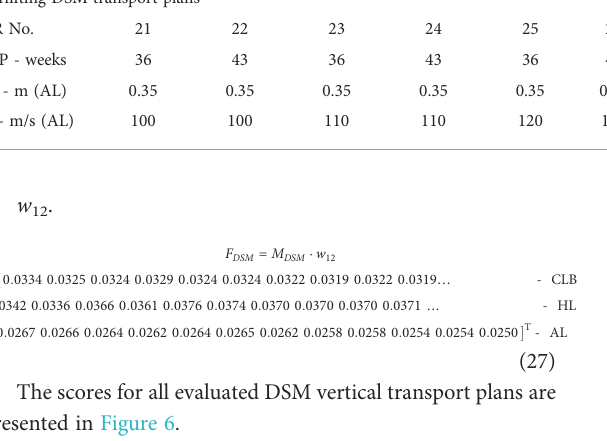
Airlifting DSM transport